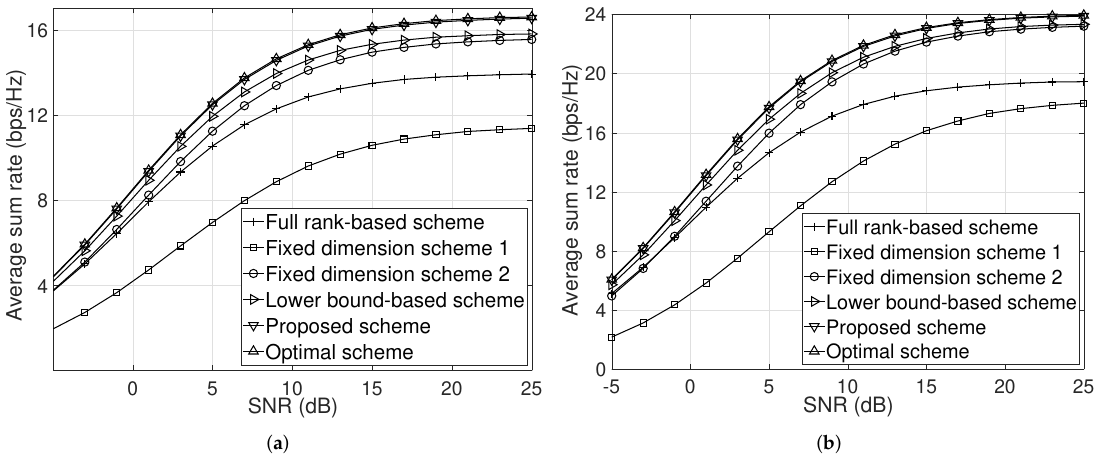
Figure 6. Comparison of the average sum rates for various schemes. ( a ) feedback bit allocation: 6 bits; ( b ) feedback bit allocation: 10